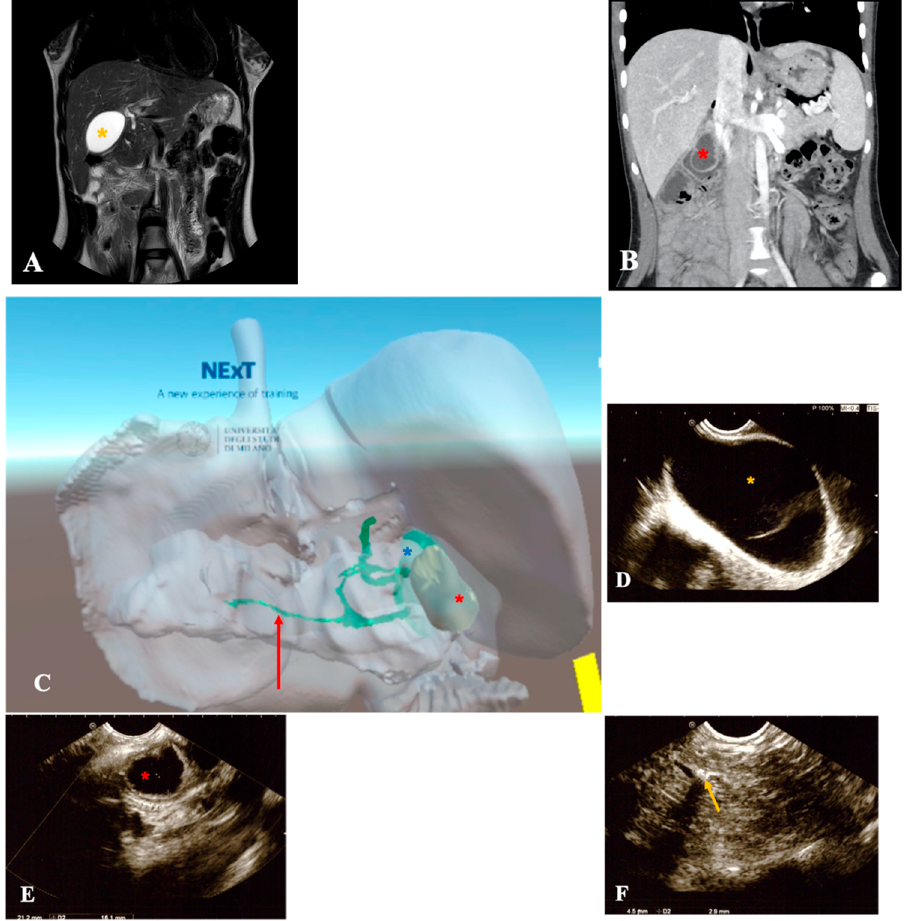
Figure 2. Patient n. 4 underwent surgery in the neonatal period for duodenal atresia. Years later, she developed symptomatic pancreato-biliary tree stones with cholelithiasis and choledocholithiasis. ( A , B ): Cholangio MRI showed a dilated gallbladder (yellow asterisk, ( A )) with stones in the in- fundibulum and the choledochal channel near a cystic dilatation. ( D – F ): EUS confirmed the presence of a dilated gallbladder (yellow asterisk, ( D )). We also identified a stone in the minor pancreatic duct (yellow arrow, ( F )). ( C ): On the posterior view of the 3D reconstructions, the choledochal channel appears to end in the upper duodenal stump with a dilatation (blue asterisk in ( C )). The pancreatic duct (red arrow in ( C ) ends in the lower duodenal stump. The upper duodenal stump also appears on endoscopic US as a blind-ending pouch (red asterisk in ( C , E